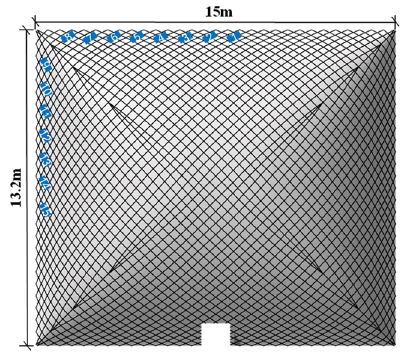
Figure 17. Sensor measuring point layout.